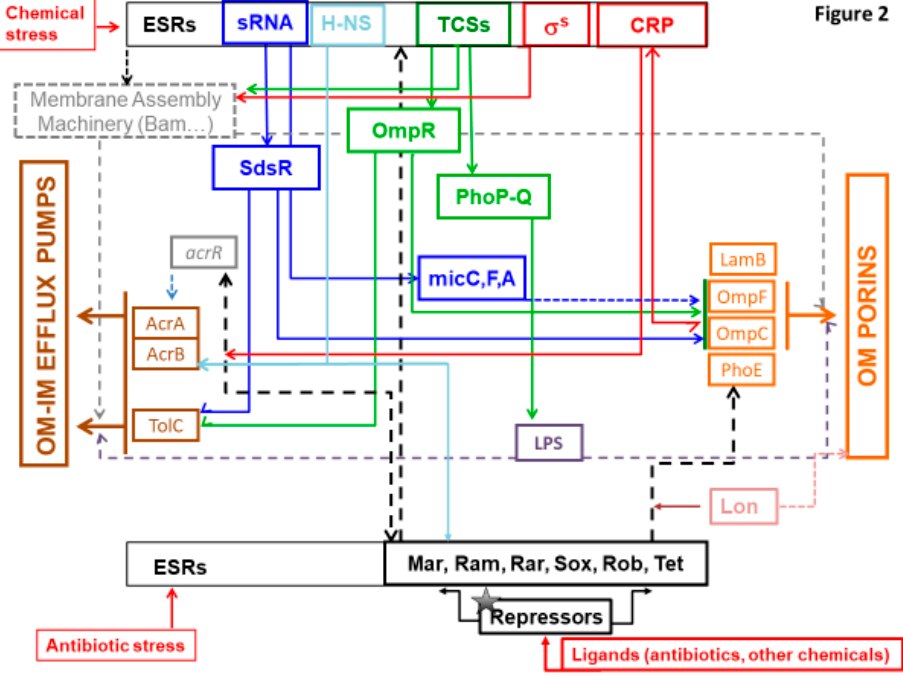
Figure 2. Schematic representation of several bacterial effectors that control membrane permeability and the In and Out of molecules. The various regulation cascades that modulate the OM permeability including porins (orange square, on the right of the diagram), and the expression of major efflux pumps (AcrAB, OqxAB; brown square, on the left of the diagram) are illustrated. In response to external stimuli (red arrows), such as chemicals including antibiotics, Envelope Stress Response (ESR) effectors are triggered and activate multiple regulation pathways, promoting the development of MDR phenotypes in Enterobacteriaceae . Among them, the major type 1 regulators including AraC-XylS family members and Tet are shown (at the bottom of the diagram) with their corresponding repressors (in black). MarA, RamA (absent in E. coli ), RarA, SoxS, and Rob activate the AcrAB-TolC expression (and OqxAB in K. pneumoniae ). They also modulate the porin expression and are involved in the membrane lipid trafficking. The Lon protease (in pink) degrades RamA and MarA. Two-component systems (TCS) (in green, at the top of the diagram) are among the main ESR effectors of type 2 regulators. They regulate processes in response to chemicals and other signals of envelope defects and subsequently controls the membrane machinery (grey square), LPS integrity (purple square), and porins expression. TCS, such as PhoPQ, induce antibiotic resistance by controlling the modification of LPS and the assembly of porins. The TCS regulator OmpR (in green) modulate the expression of the major porins under an osmotic stress, promoting a resistance to B-lactams. The H-NS (in light blue) is also involved in the response to osmotic stress and regulates the expression of efflux pumps and porins in E. coli and K. aerogenes . The Sigma factor (in red) regulates genes involved in expression of membrane protein. The sRNAs (in blue) regulate (and are regulated by) the ESRs. They have multiple mRNA target and allow to mediate a rapid and e ffi cient response. sRNAs such as MicF, MicC, MicA (in blue) are involved in the regulation of porins expression. sRNAs also mediate the regulation of e ffl ux pump expression with, for instance, the binding of SdsR (in blue) to the TolC mRNA. The Cyclic AMP Receptor Protein (CRP, in red), one of the most important TF in E. coli , is also involved in the regulation of e ffl ux systems and porins expression. Overall, ESR e ff ectors regulate LPS biogenesis that is involved in the OM proteins assembly and, consequently, the function of porins and TolC (grey dashed